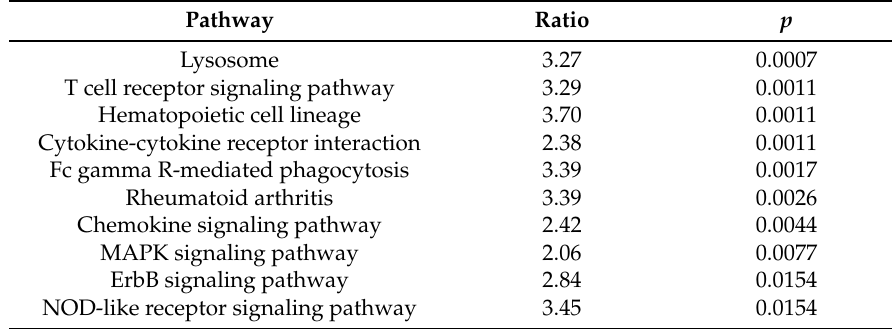
Figure 1. Guanabenz-driven suppression of inflammatory gene expression. The single and double asterisks indicate p < 0.05 and p < 0.01, respectively. ( A ) Levels of IL1 β , IL6, TNF α , and Cox2 mRNAs in LPS-stimulated RAW264.7 cells in response to 10 µM guanabenz; ( B ) levels of IL1 β , IL6, TNF α , and Cox2 mRNAs in LPS-stimulated primary macrophages in response to 10 µM guanabenz; ( C ) levels of IL2 and IFN γ mRNAs in PMA-stimulated Jurkat cells in response to 5 and 10 µM guanabenz; ( D ) levels of TNF α and IL13 mRNAs in PMA-stimulated HMC1.1 cells in response to 10 µ M guanabenz. Table 1. Microarray-based prediction of pathways. Selected Kyoto Encyclopedia of Genes and Genomics (KEGG) pathways for primary macrophages.